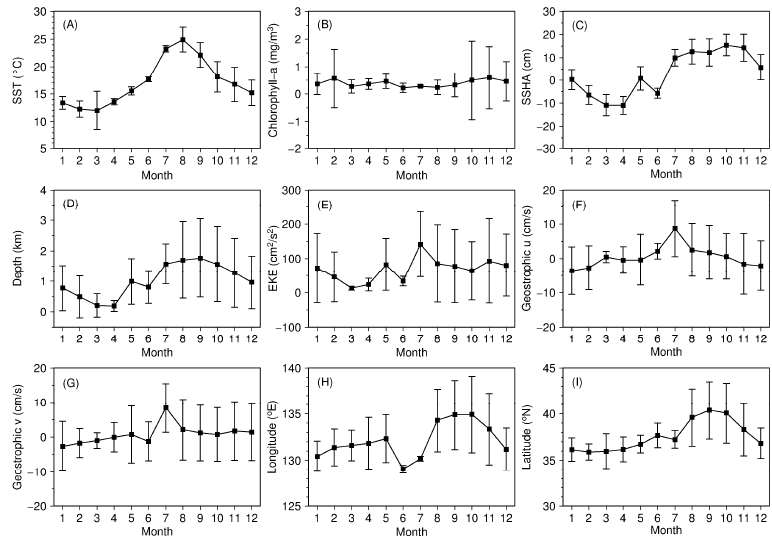
Figure 2. Monthly time-series of the ( A ) SST, ( B ) Chl- a , ( C ) SSHA, ( D ) Depth, ( E ) EKE, ( F ) geostrophic u , ( G ) geostrophic v , ( H ) longitude, and ( I ) latitude at the squid fishing locations from January–December, 2010–2013. Vertical bars correspond to the ±1 standard deviation.